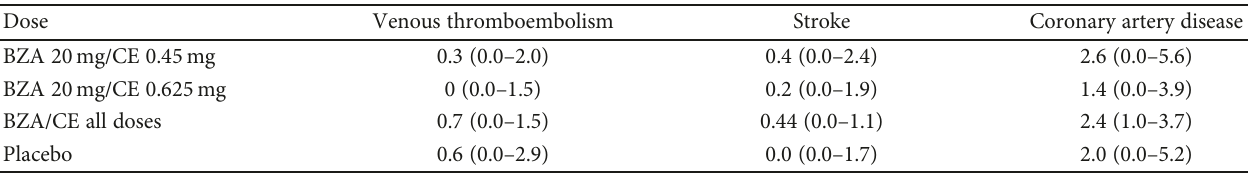
Table 4: Cardiovascular events (venous thromboembolism, stroke, and coronary artery disease) reported in SMART trials (data presented as incidence per 1000 women/year, CI 95%)